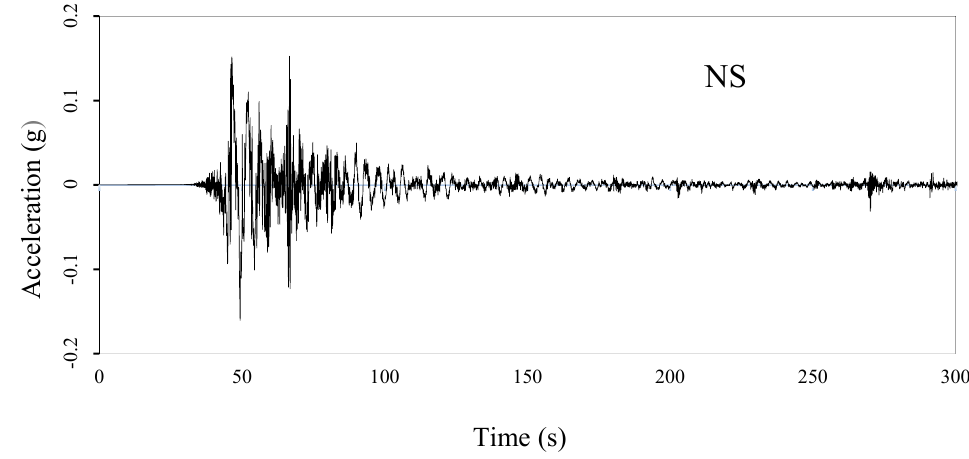
Figure 4. Acceleration time history of Gorkha earthquake (North-South component) at KATNAP station.